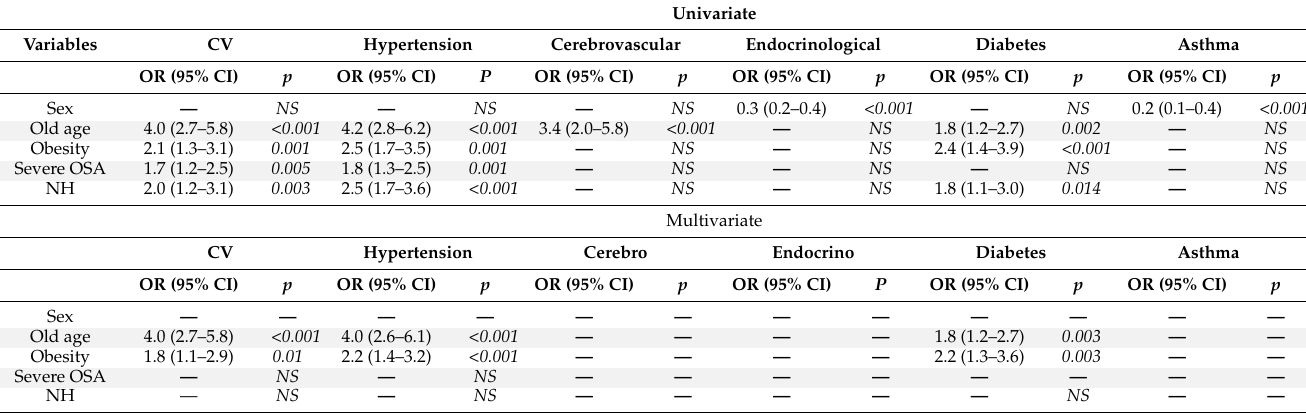
Table 2. Evaluation of disease risk in a population with obstructive sleep apnoea (OSA). Univariate